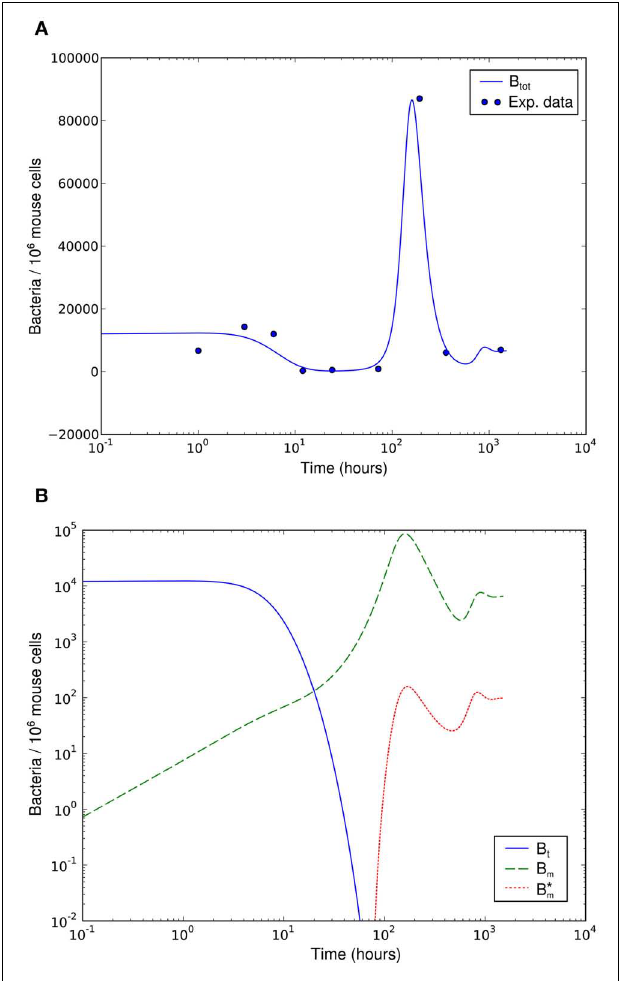
FIGURE 7 | Numerical simulation of the BB infection model with adaptation of the spirochaetes and humoral immune response. (A) Total number of spirochaetes per 10 6 mouse cells in experiment (Pahl et al., 1999) and simulation.The parameters used are described in Table 2 .The simulation result is shown as the sum of all three BB sub-populations. (B) Borrelia sub-populations. B t is the initial, vulnerable BB population, B m the adapted, resistant one, and B ∗ antibody-bound m